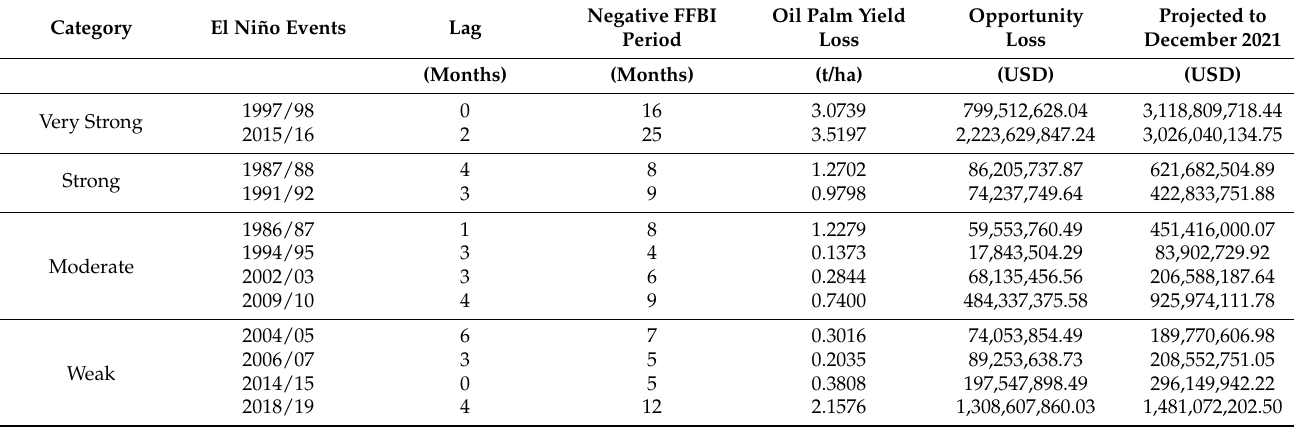
Table 8. Oil palm yield loss and opportunity loss due to each El Niño event from January 1986 to June